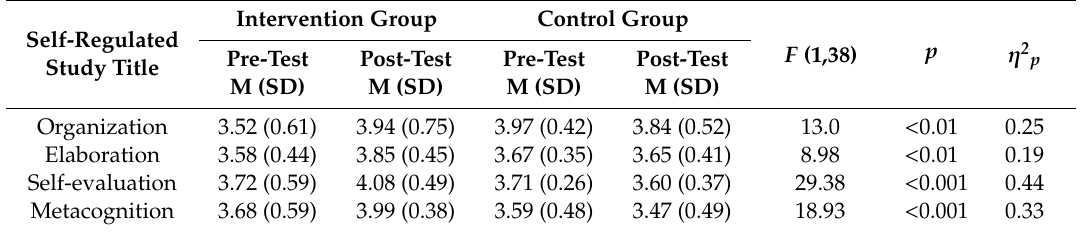
Table 4. Learning and studying abilities (Study Approach Questionnaire,